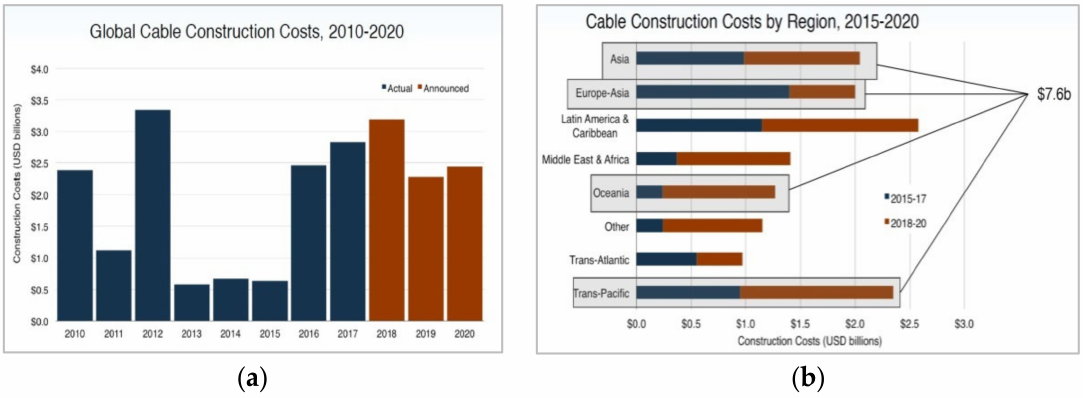
Figure 33. ( a ) Global cable construction costs for the period ranging from 2010–2020. ( b ) Costs by region [86].